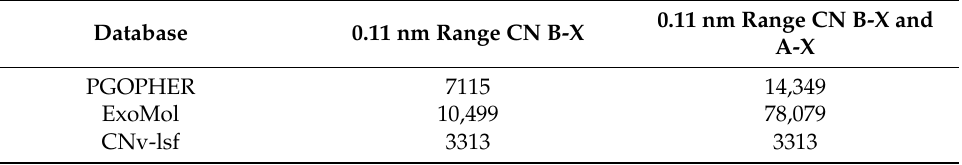
Table 9. Number of transitions of the simulated spectra in the measured experimental ranges for